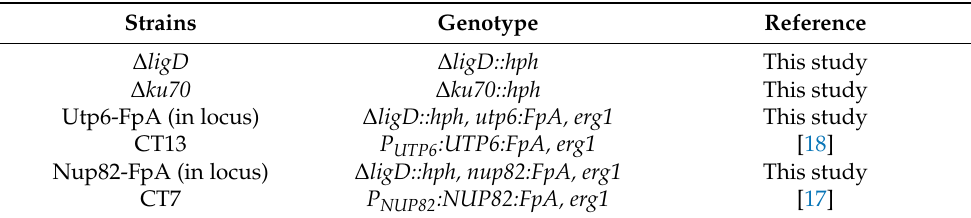
Table 1. Genetically modified C. thermophilum strains used in this study. Strains Genotype Reference ∆ ligD ∆ ligD::hph This study ∆ ku70 ∆ ku70::hph This study Utp6-FpA (in locus) ∆ ligD::hph, utp6:FpA, erg1 This study CT13 P UTP6 :UTP6:FpA, erg1 [18] Nup82-FpA (in locus) ∆ ligD::hph, nup82:FpA, erg1 This study CT7 P NUP82 :NUP82:FpA, erg1 [17] Homologous integration of the constructs was verified by Southern analysis [43]. Therefore, the DIG High Prime DNA Labeling and Detection Starter Kit II (Roche, Mannheim, Germany, cat. no. 11585614910) was used according to the manufacturer’s instructions. Digoxigenin-labelled